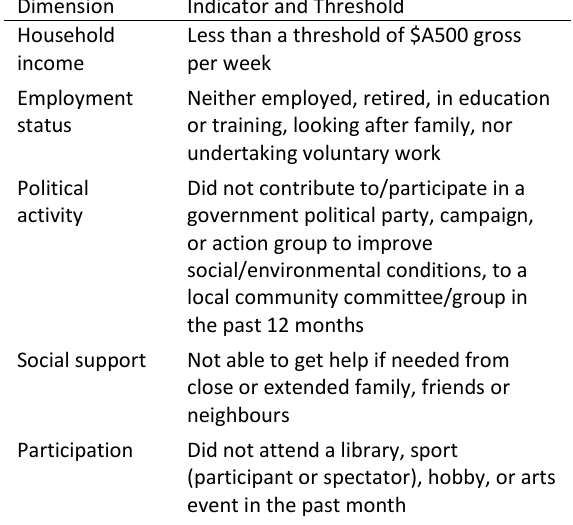
Table 1. Australian Indicators of social exclusion.